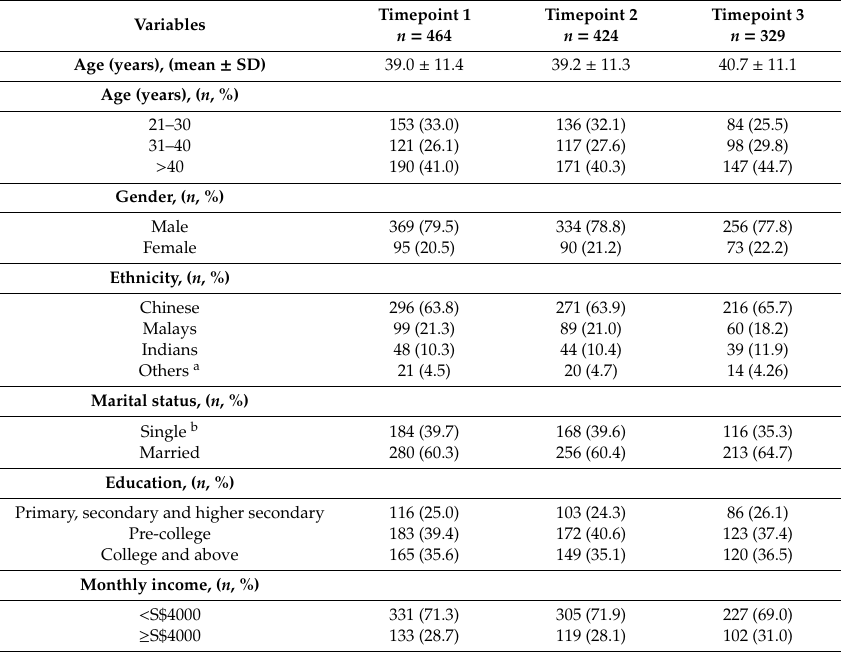
Table 1. Socio-demographic characteristics of the study cohort at each